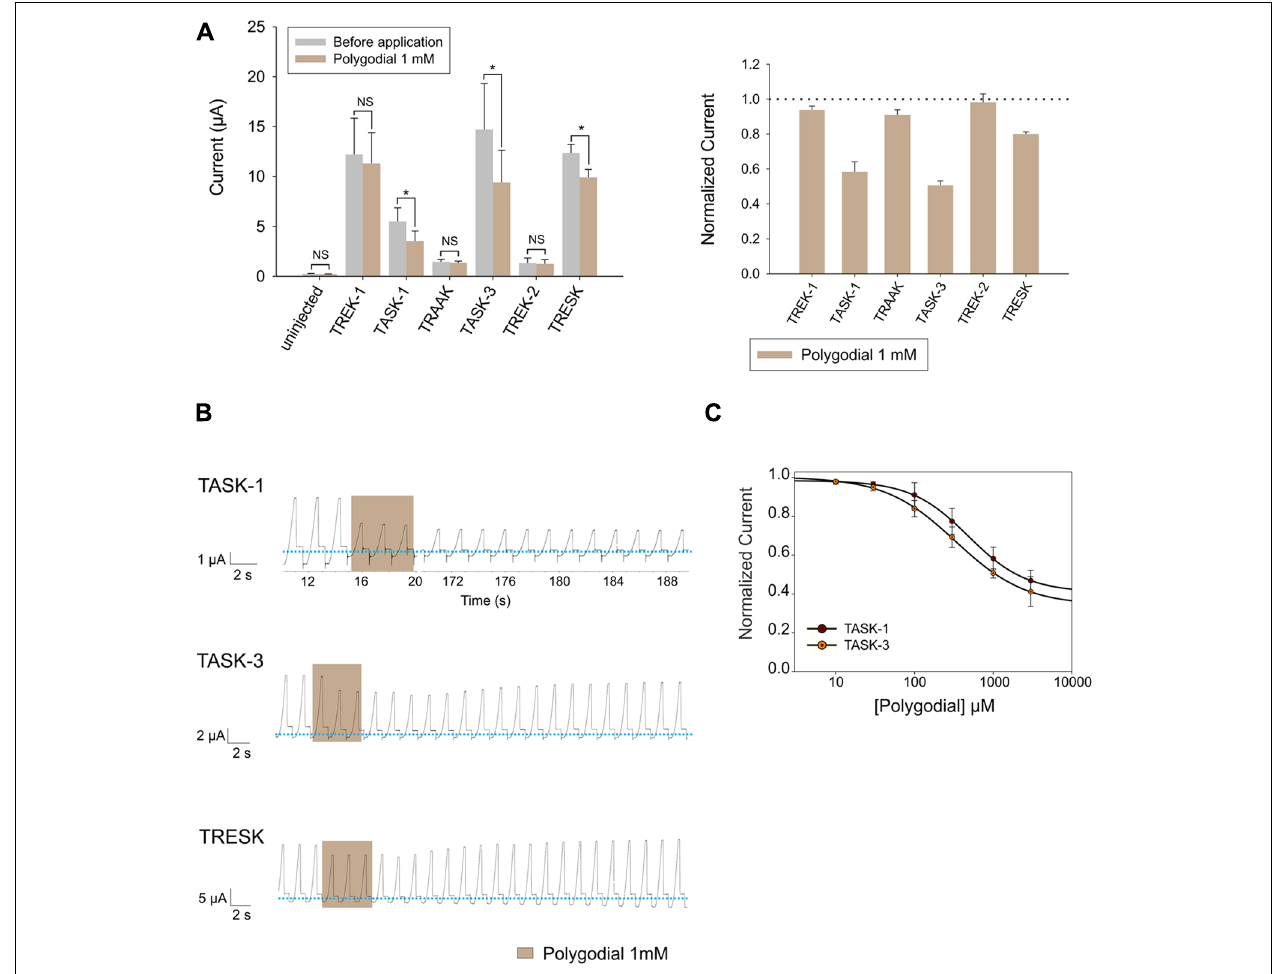
FIGURE 5 | (A) Left (from left to right) absolute currents presented by: uninjected Xenopus oocytes, oocytes injected with cRNA coding for hTREK-1, hTASK-1, hTRAAK, hTASK-3, hTREK-2 and hTRESK, before and after the application of 1 mM polygodial. Right . Normalized currents showing the effect of 1 mM polygodial on Xenopus oocytes injected with cRNA coding for hTREK-1, hTASK-1, hTRAAK, hTASK-3, hTREK-2 and hTRESK. For each group, the current was normalized to the current registered prior to the application of 1 mM polygodial (dotted line). All data are expressed as the mean + / − SEM.